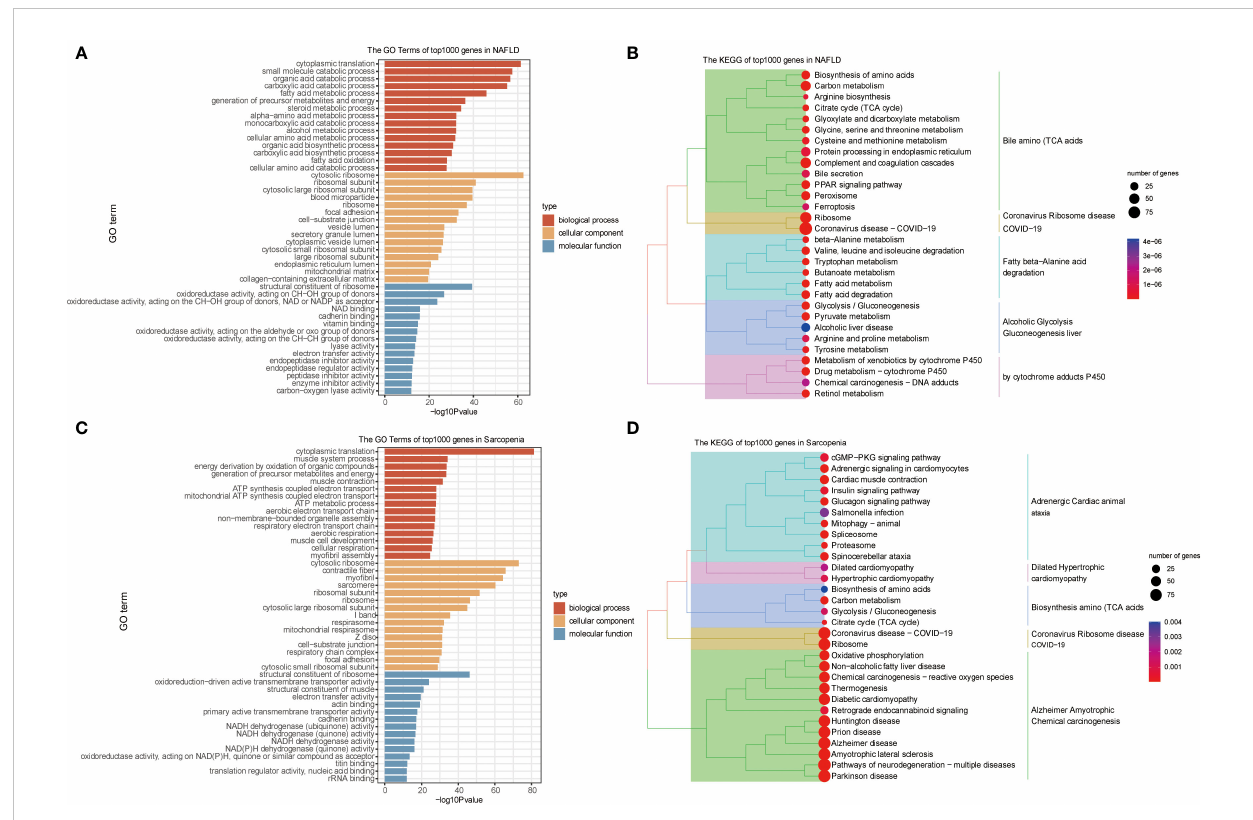
FIGURE 2 GO and KEGG Pathway Analyses of NAFLD and Sarcopenia. (A) The enriched GO terms of the top 1000 genes in NAFLD; (B) The KEGG of the top 1000 genes in NAFLD; (C) The enriched GO terms of the top 1000 genes in Sarcopenia; (D) The KEGG of the top 1000 genes in